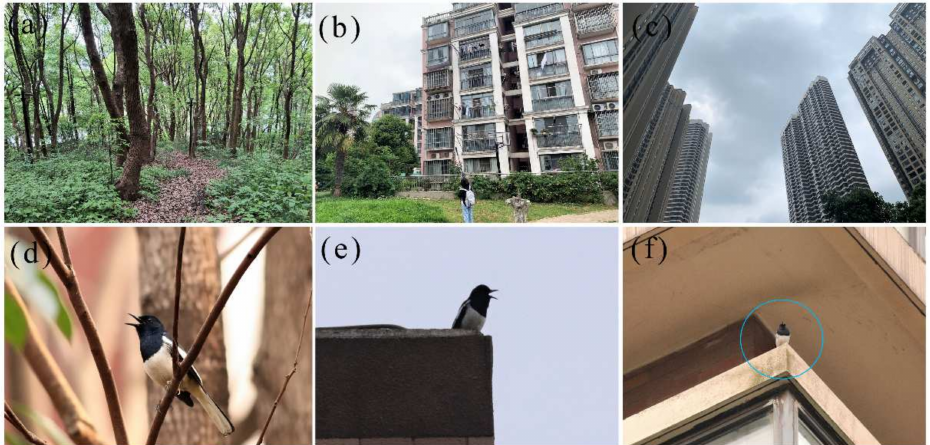
Figure 1. The three habitat types (( a ) urban park; ( b ) low-rise residential area; and ( c ) high-rise residential area) investigated in the urban area of the city of Wuhu, and individual oriental magpie- robins singing in different habitats (( d ) in a tree in an urban park; ( e ) on the roof of a low-rise residential area; and ( f ) in the middle of the floor of a high-rise residential